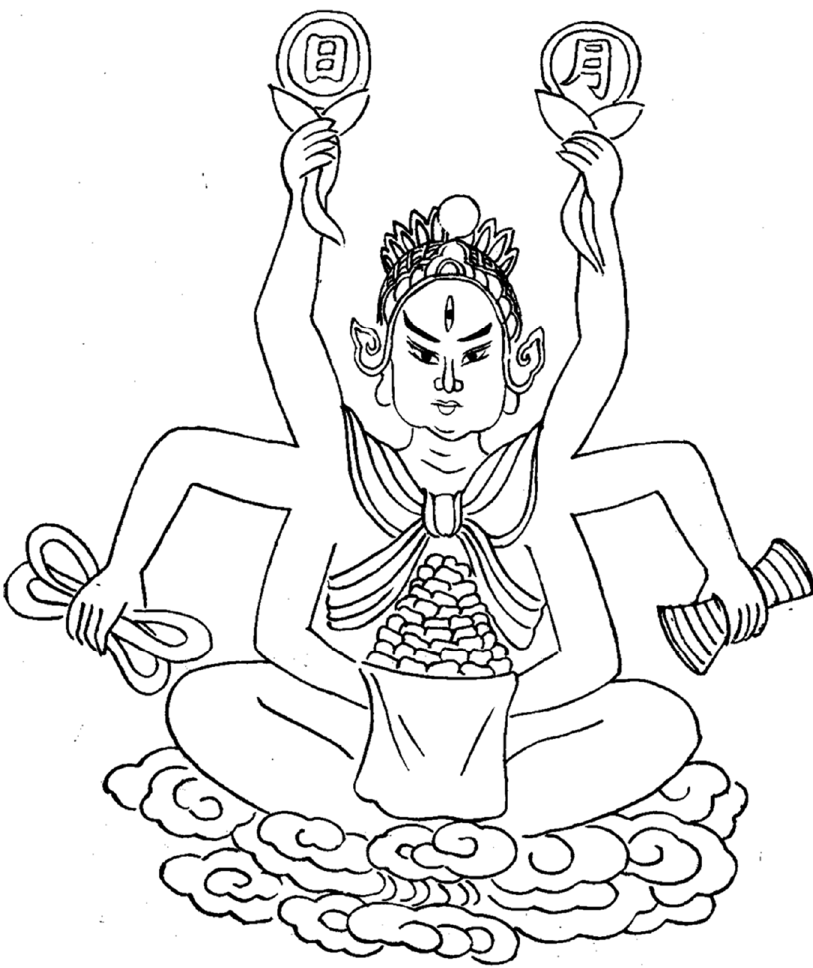
Figure 12. “Can Hua Wu Sheng 蚕花五圣 ” (Gu 1991, p. 101).